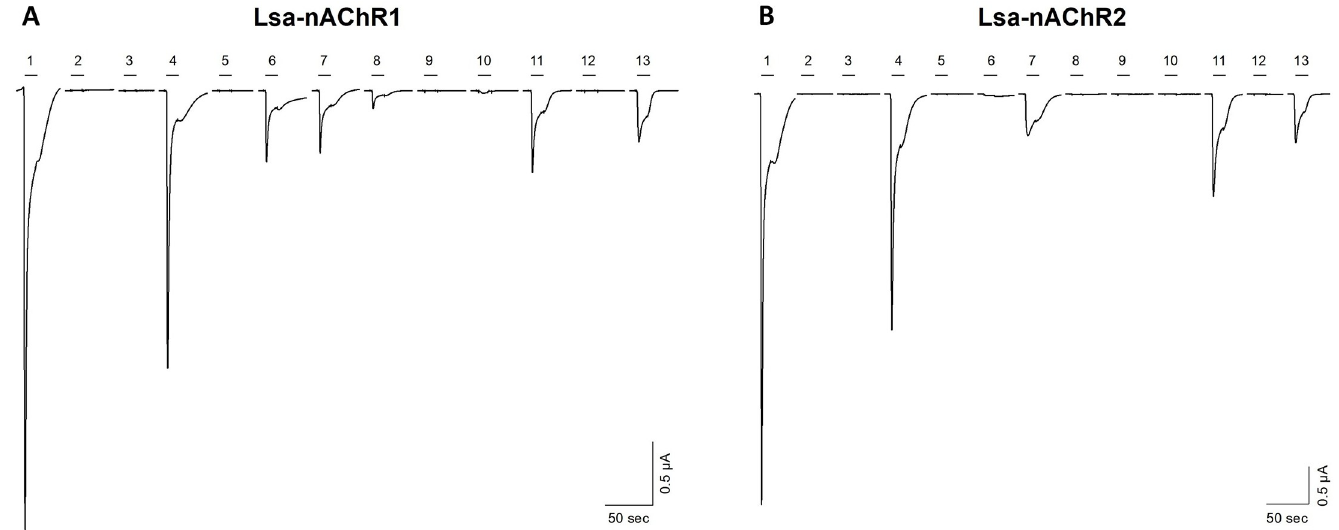
Fig 6. Agonist screening on Lsa-nAChR1 and Lsa-nAChR2. Typical current traces obtained with different agonists tested on Lsa-nAChR1 (A) or Lsa-nAChR2 (B). ACh (1) was tested at 100 μ M) while all other compounds (2 to 13) were tested at 1 μ M. 1) acetylcholine 100 μ M; 2) azamethiphos; 3) emamectin; 4) nitenpyram; 5) deltamethrine; 6) thiacloprid; 7) clothianidin; 8) imidacloprid; 9) thiamethoxam; 10) acetamiprid; 11) dinotefuran; 12) cypermethrin; 13) acetylcholine 1 μ M. https://doi.org/10.1371/journal.ppat.1008715.g006 3.95 μ M and 9.98 μ M with maximal peak currents compared to ACh of 27.9% and 16.1% for Lsa-nAChR1 and Lsa-nAChR2, respectively (Table 2 and S4 Fig). Only six of the seven nicoti- noids were able to activate Lsa-nAChR1, whereas only three worked as agonists for Lsa- nAChR2. Thiacloprid was the most effective compound and worked as a partial-agonist of Lsa-nAChR1, with an EC measured at 12 nM only and a maximal peak current of 6.1% 50 (compared to ACh; Table 2 and S4 Fig). Interestingly, it did not show any effect when tested on Lsa-nAChR2. The same was observed with imidacloprid but with a slightly higher EC (69 50 nM) and higher maximal currents (31.8%) on Lsa-nAChR1 and no effect on Lsa-nAChR2